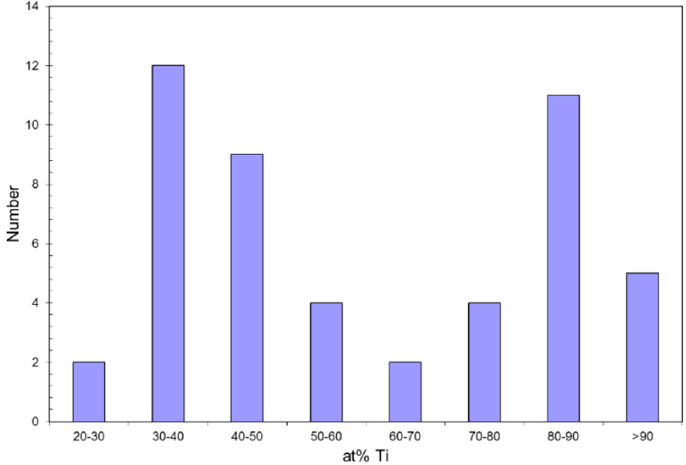
Figure 7. Number of precipitates, in Groups 2 and 3, as a function of measured Ti composition.